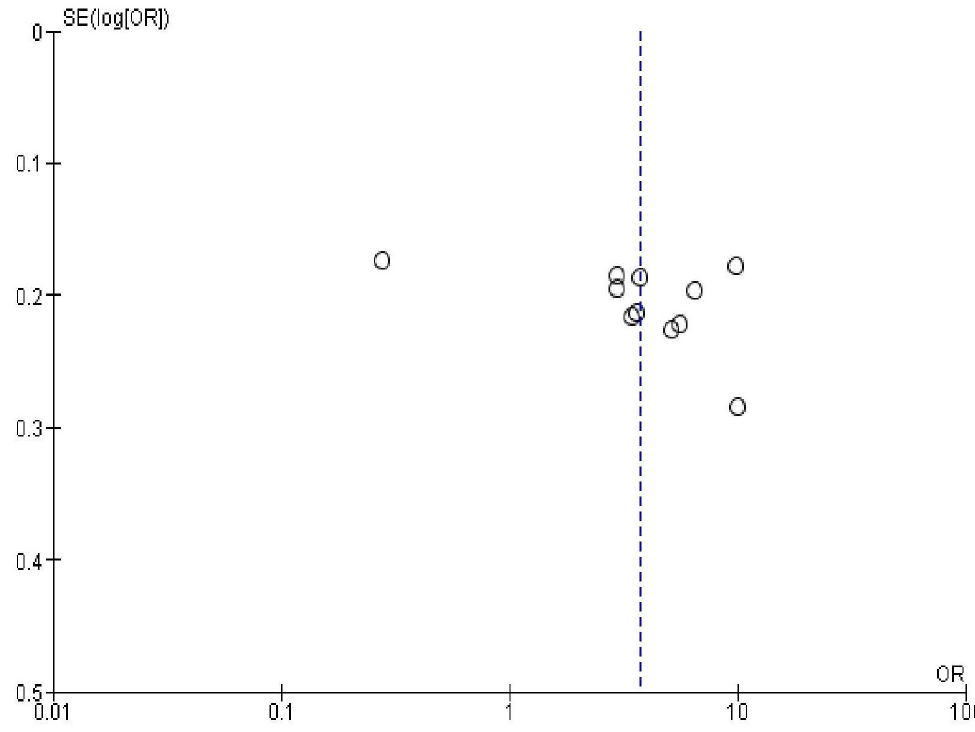
Fig 16. Publication bias on menses return after birth.